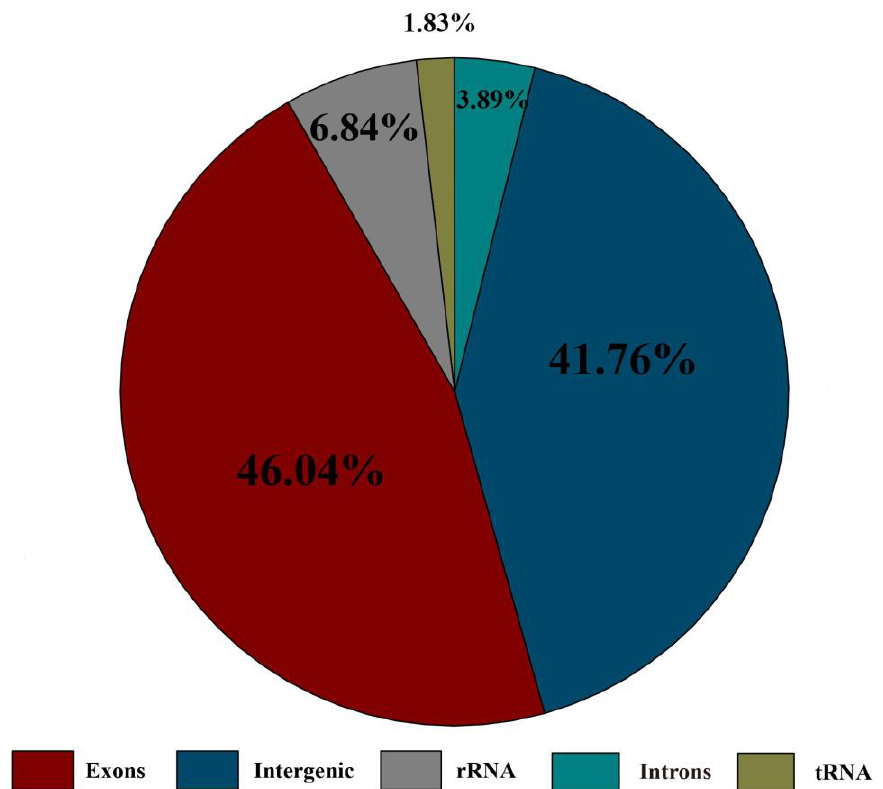
Figure 3. Proportions of the whole chloroplast genome of Trebouxiophyceae sp. DW1. The exons, introns, intergenic sequences, tRNA, and rRNA genes region.